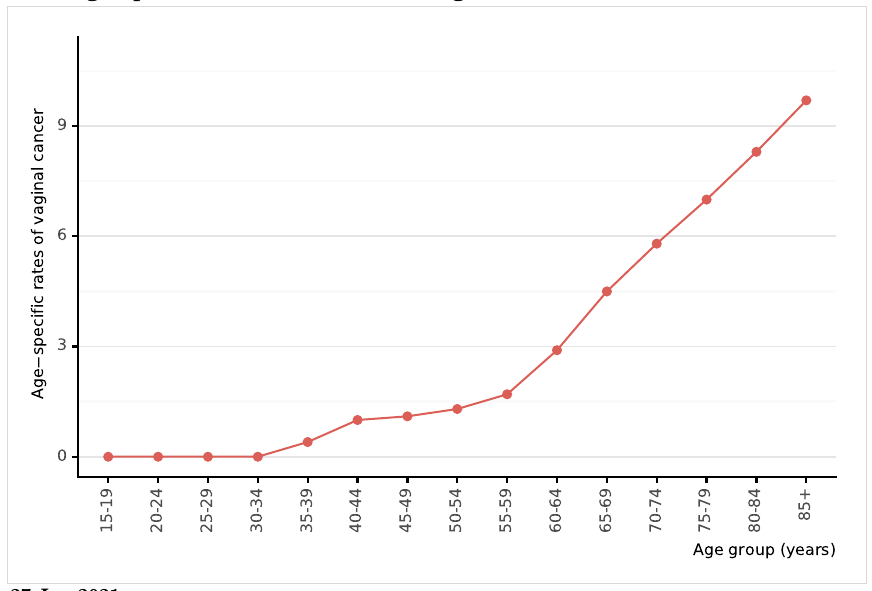
Figure 26: Age-specific incidence rates of vaginal cancer in India (estimates for 2020)